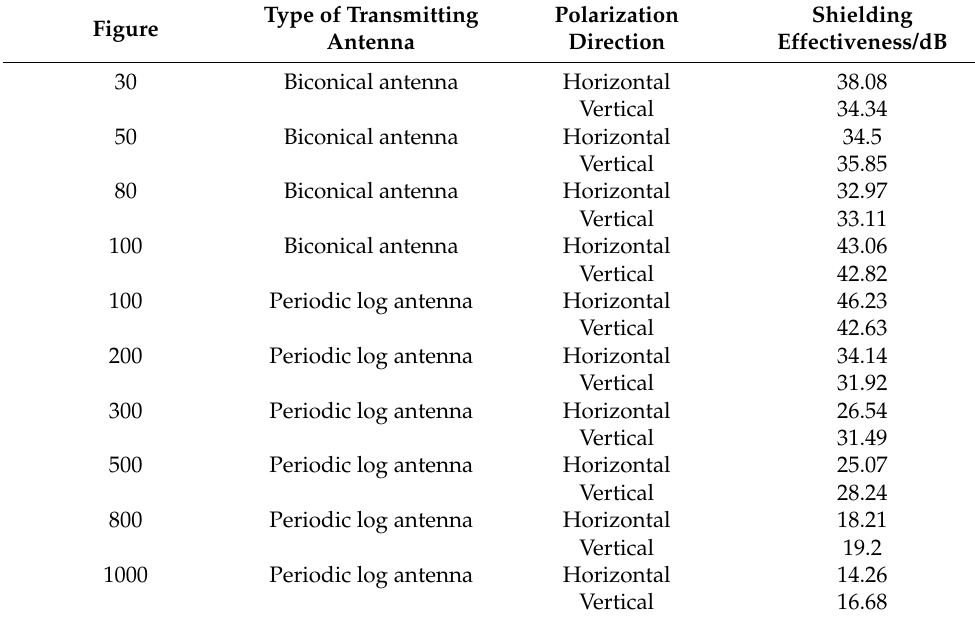
Table 3. Shielding effectiveness of point No. 1 in the center of the test cavity observation points.